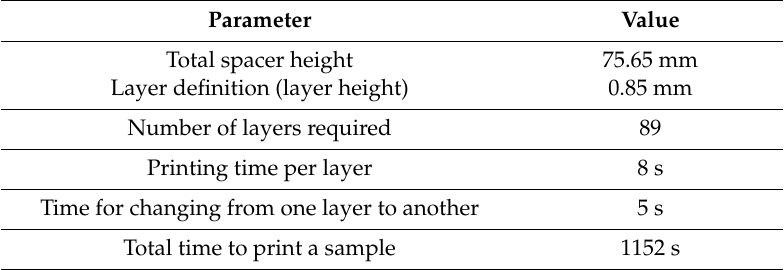
Table 2. First scenario for comparison (conventional robocasting): calculation of the total time to print an analogous tall sample (cylindrical spacer of the same external dimensions) in robocasting of multiple